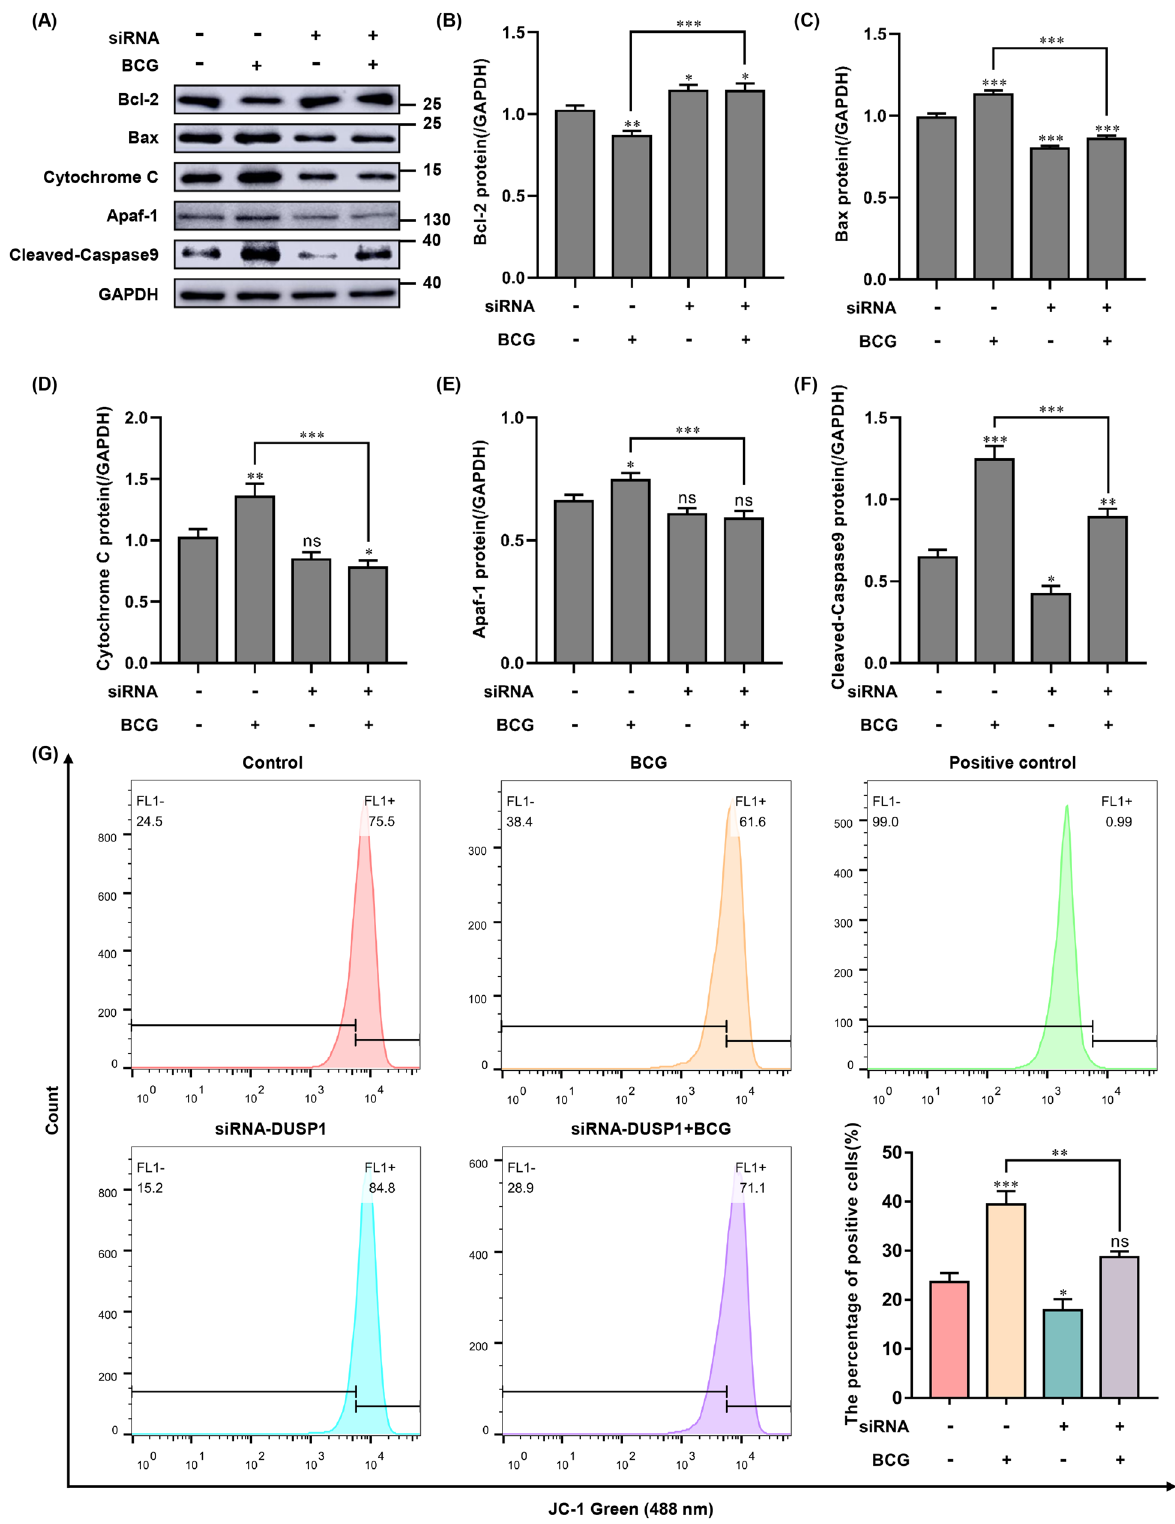
Figure 4. Effect of knockdown of DUSP1 on the expression of key proteins of BCG-induced endogenous apoptosis pathway in macrophages. ( A ) THP-1 cells were transfected with siRNA-NC (negative control) or siRNA-DUSP1 for 24 h, and then infected with BCG and cultured for 6 h. The expression levels of endogenous apoptotic pathway key proteins Bcl-2, Bax, cytochrome C, Apaf-1, cleaved-Caspase9 were detected using Western blotting. ( B – F ) Endogenous apoptotic pathway key results of grey-scale analysis of protein expression. ( G ) THP-1 cells were transfected with siRNA-NC (negative control) or siRNA-DUSP1 for 24 h, and then infected with BCG and cultured for 6 h. Mitochondrial membrane potential was detected by flow cytometry. All data are represented as mean ± SD (n = 3). (* p < 0.05, ** p < 0.01, *** p <